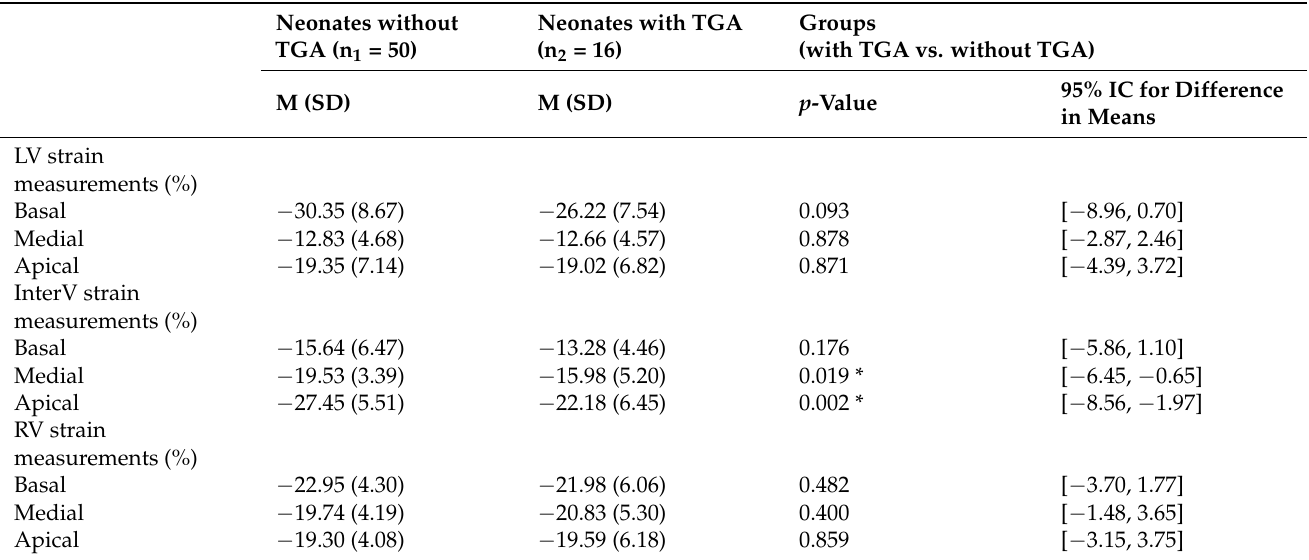
Table 5. Distributions of regional strain measurements in studied groups (neonates with TGA